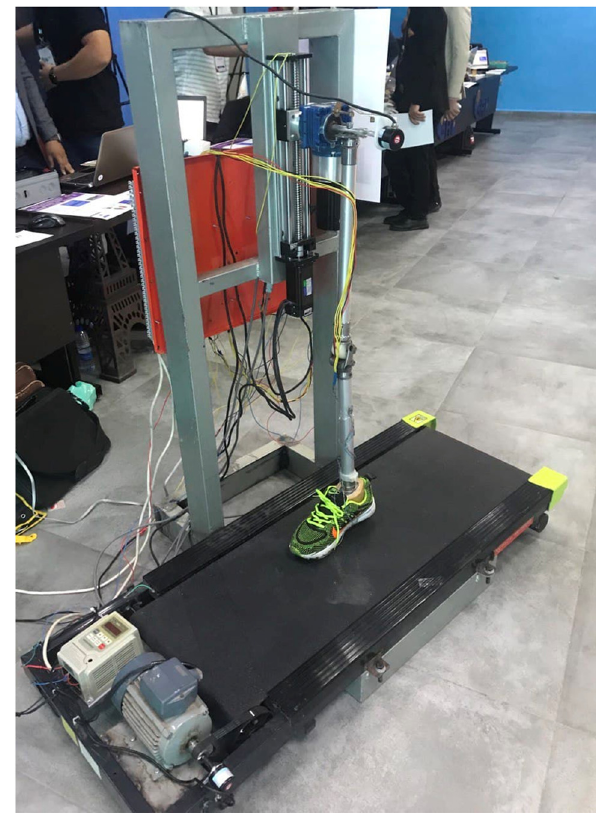
Figure 4: The gait emulator device of experimental work.